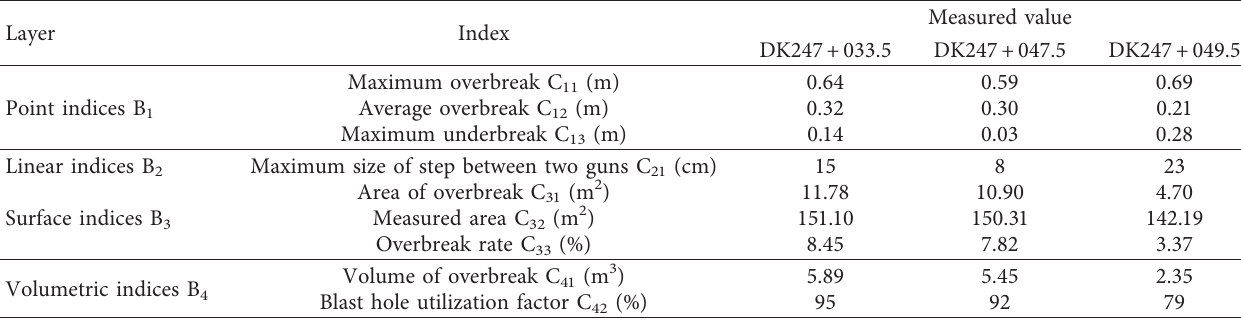
Table 18: Collected indices representing the contour quality after smooth blasting.